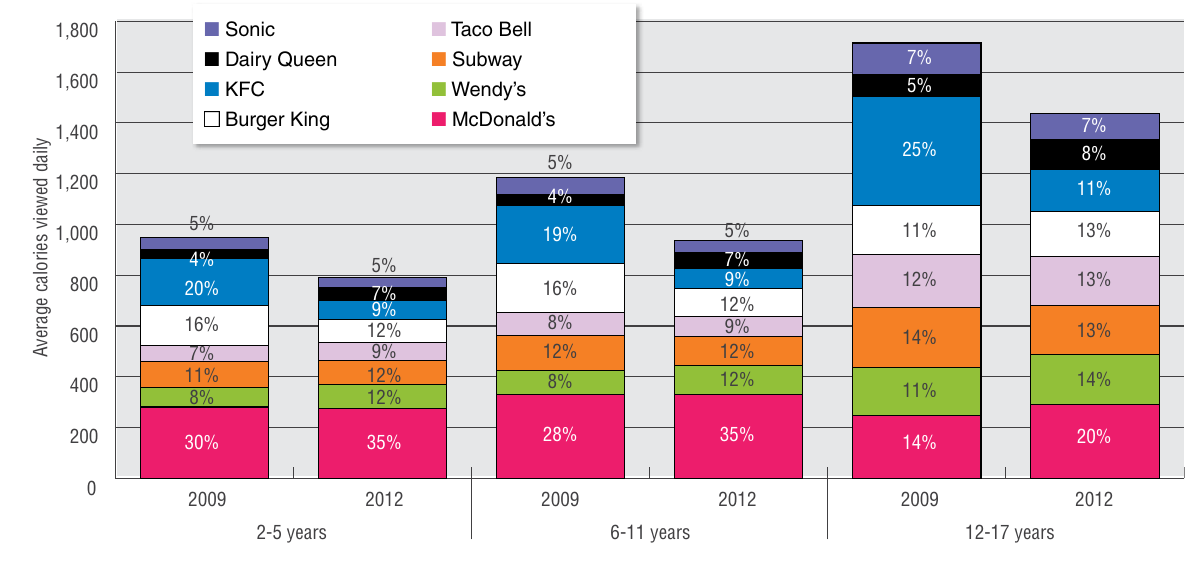
Figure 12. Calories viewed daily in TV ads for fast food